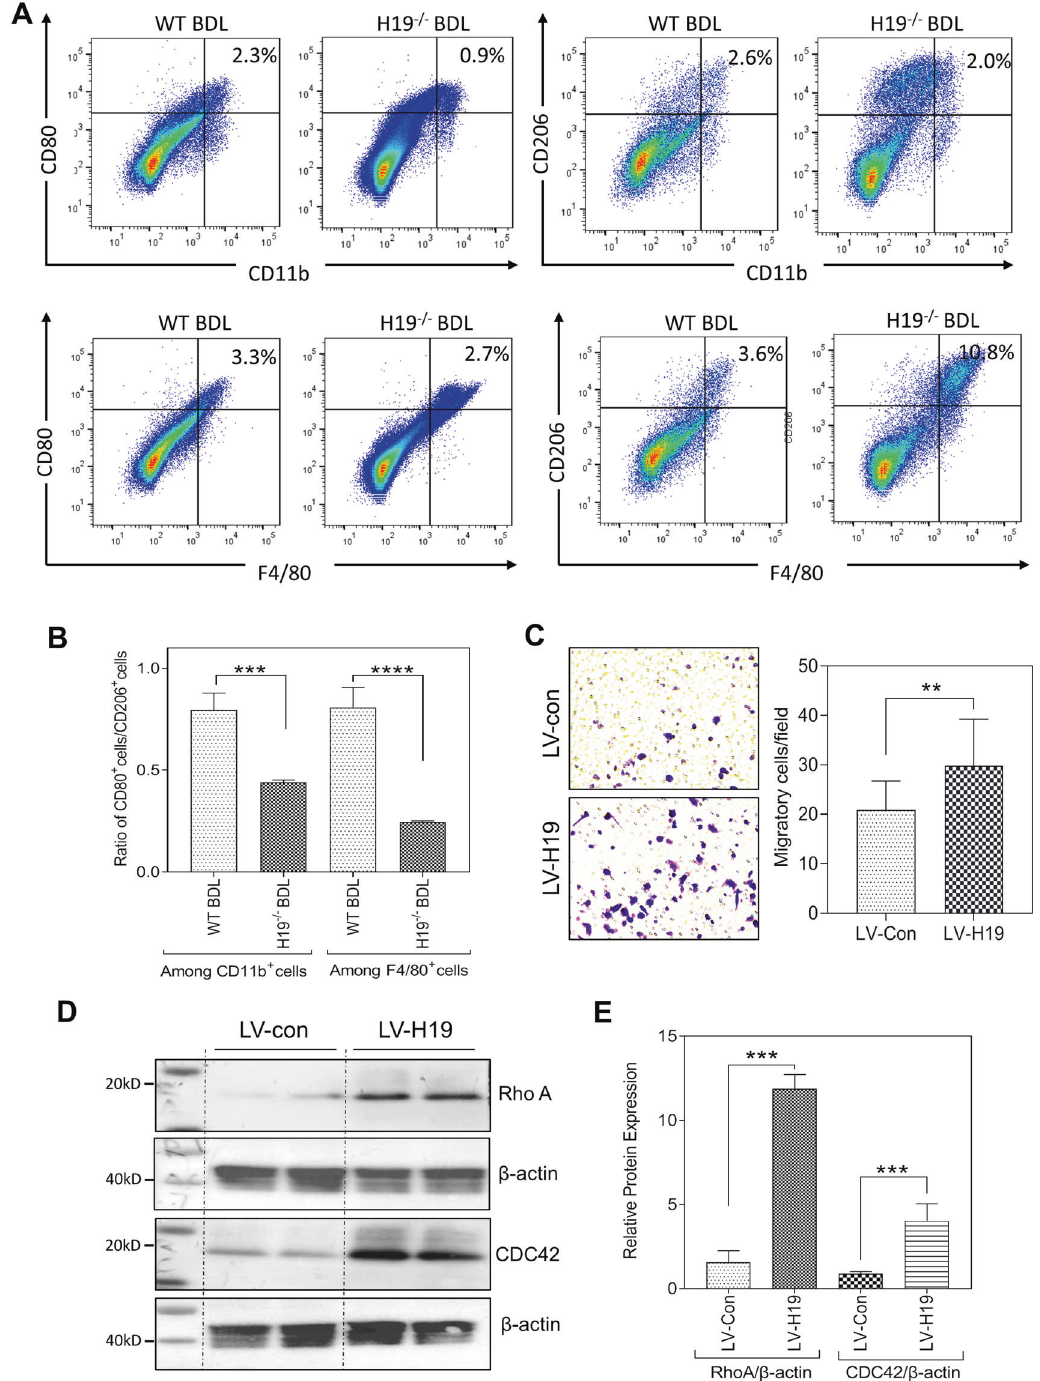
Fig. 8 H19 knockout leads to skew macrophage polarization toward M2 subtype. A Representative fl ow cytometry results and images of the percentage of indicated cells in all monocytes are shown. B The ratio of CD80/CD206-positive cells in Kupffer cells and monocyte-derived macrophages. C Representative images of migration assay are shown. D The expression of RhoA and CDC42 in THP-1 macrophages that infected with lentivirus-control (LV-Con) or lentivirus-H19 (LV-H19). E Quanti fi cation of panel D . Results from at least three independent experiments are presented as mean ± SD. * P < 0.05; ** P < 0.01, *** P <